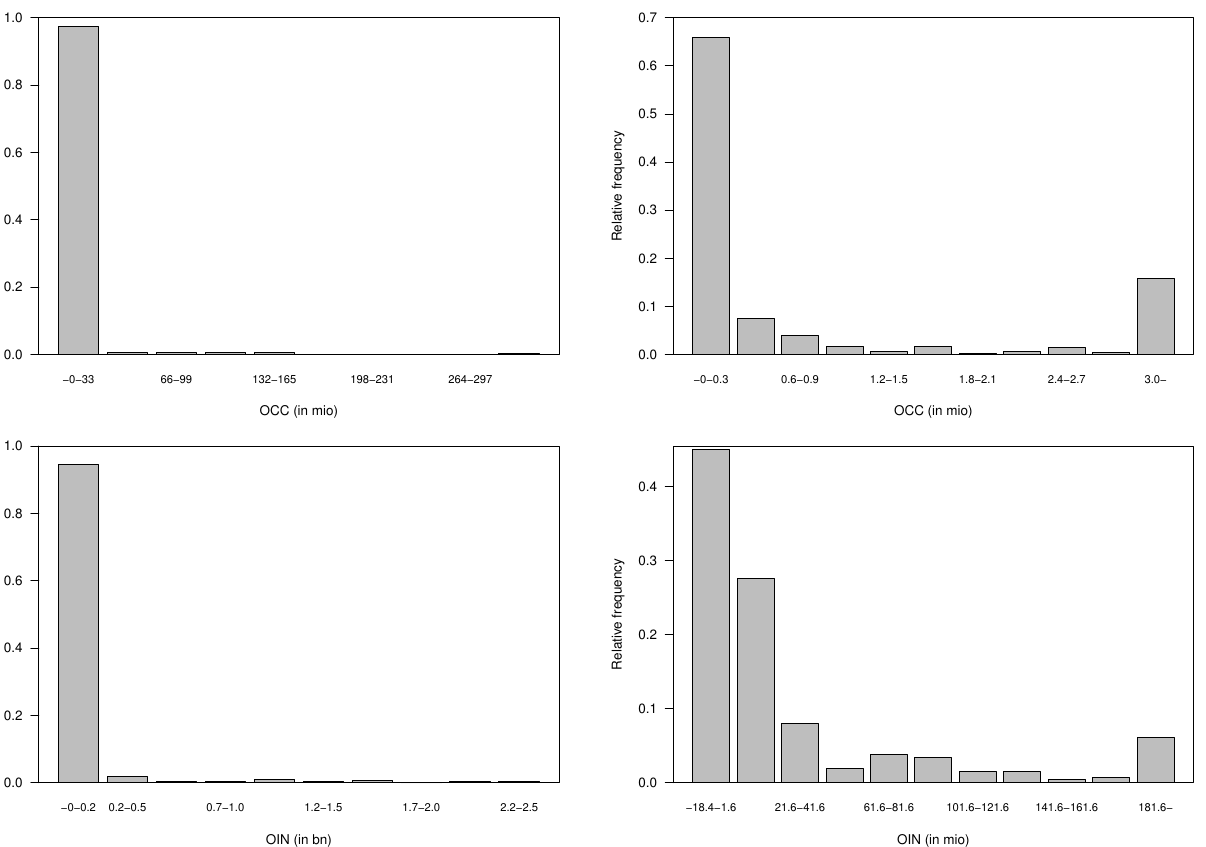
Figure A9. Relative frequency of the operation cost, administration cost and commission ( ACC ) and other costs ( OCC ), and of the other income ( OIN ) for non-life undertakings. The figure presents twice the relative frequency of ACC , OCC and OIN : ACC and OCC are once sliced by billion and once sliced by million. OIN is sliced in two different intervals.